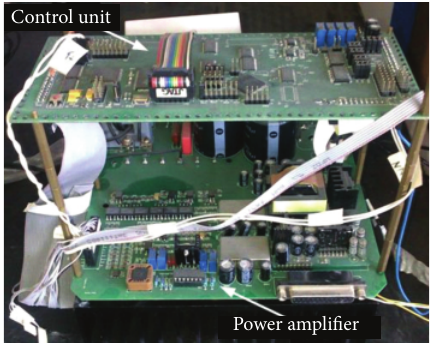
Figure 12: Digital driving